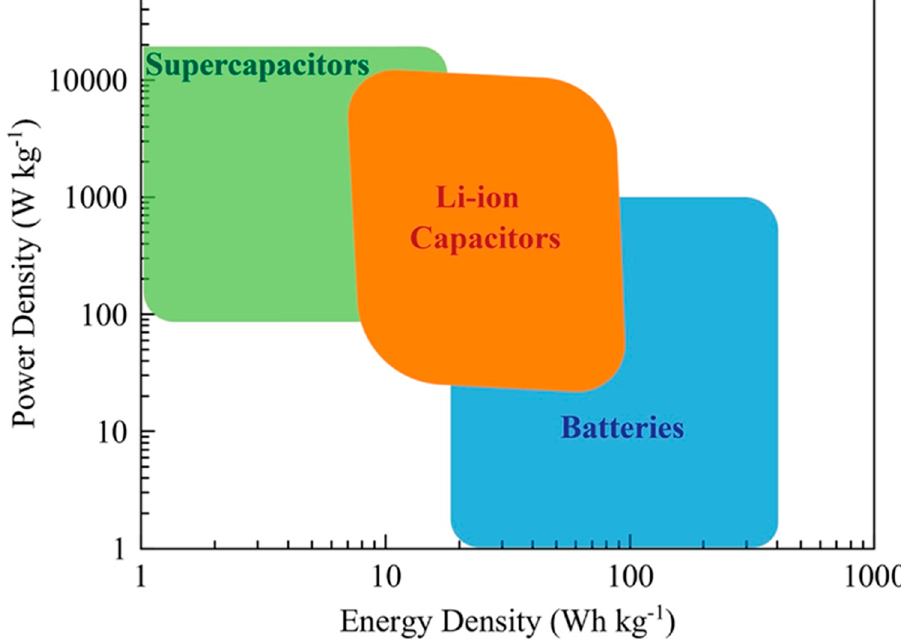
Figure 1. Qualitative Ragone plot reported in normalized terms of mass of the whole device. The shaded areas are reported in gravimetric terms.